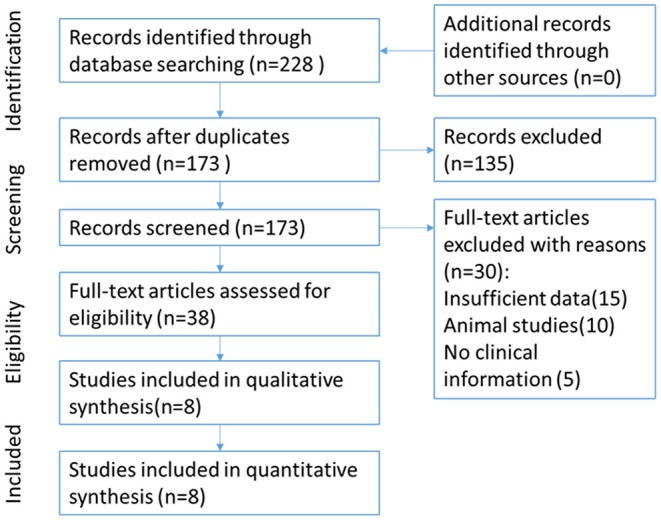
Flow chart for selection of studies.